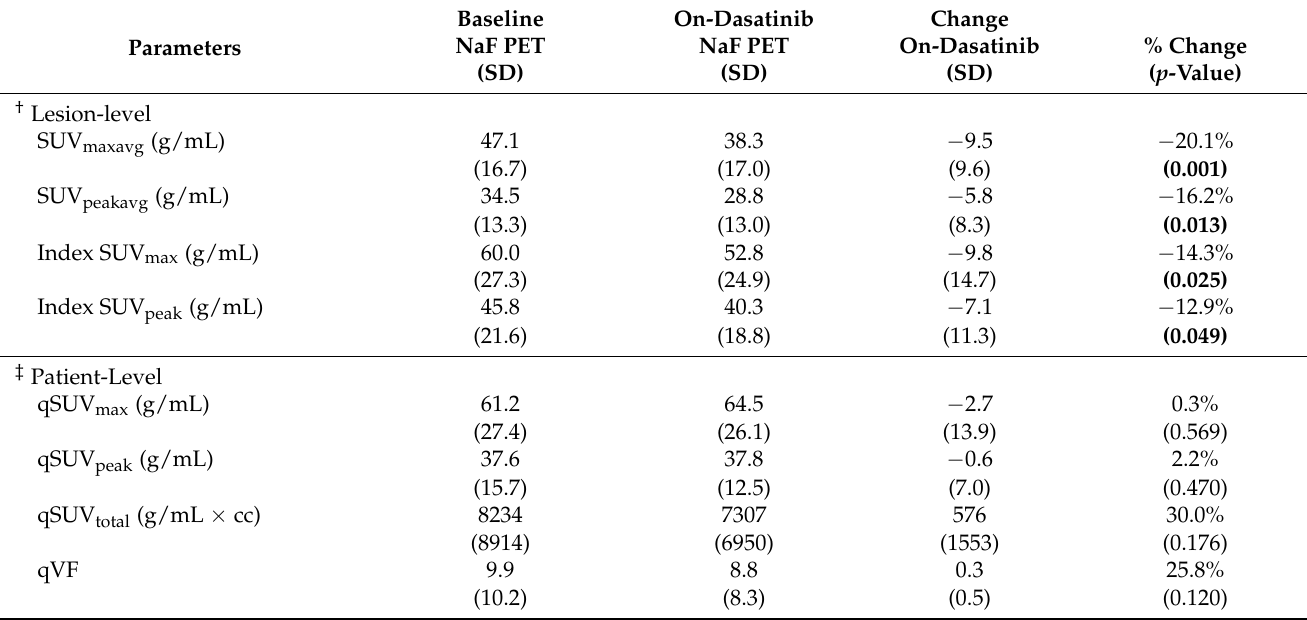
Table 2. [ 18 F]-Fluoride uptake parameters in bone